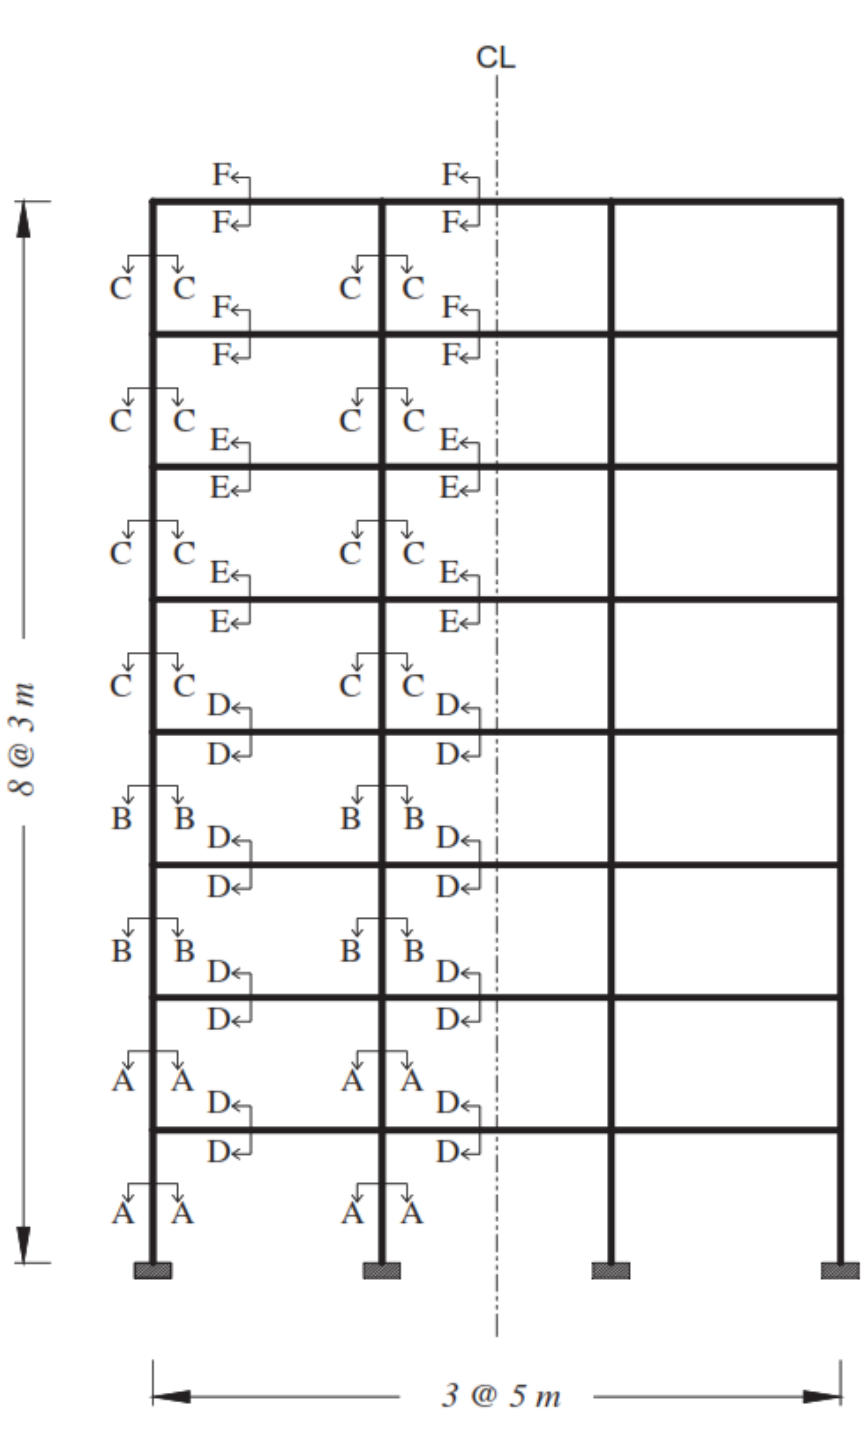
Figure 5. The selected moment ‐ resisting frame [34]. Table 4. The details of the designed frame (mm)